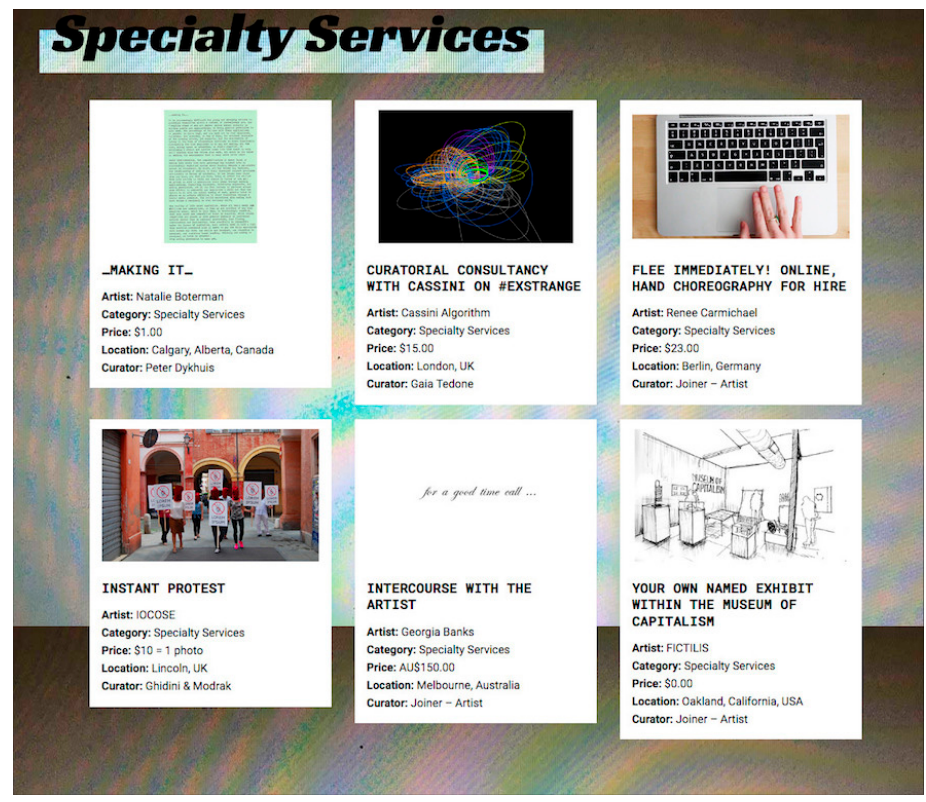
Figure 13. #exstrange—Archive , 2017. Screenshot of archive page (partial). © #exstrange, 2019.